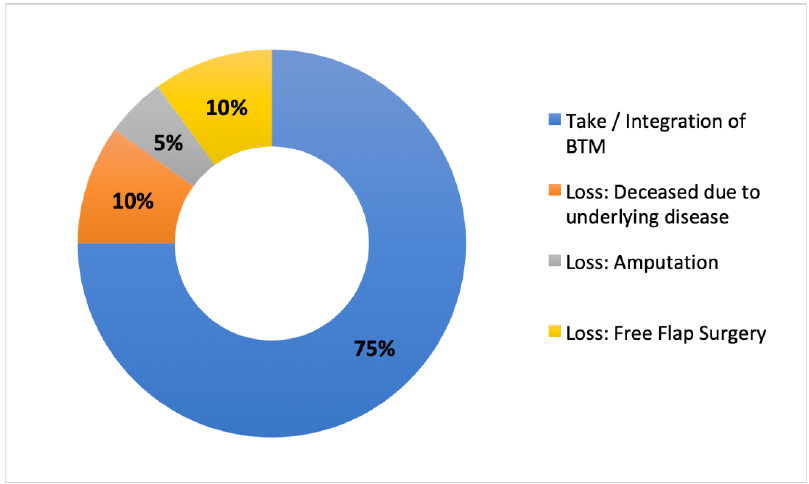
Figure 2. Overview of integration of NovoSorb ® Biodegradable Temporising Matrix (BTM) in the treatment of complex wounds ( n = 20).